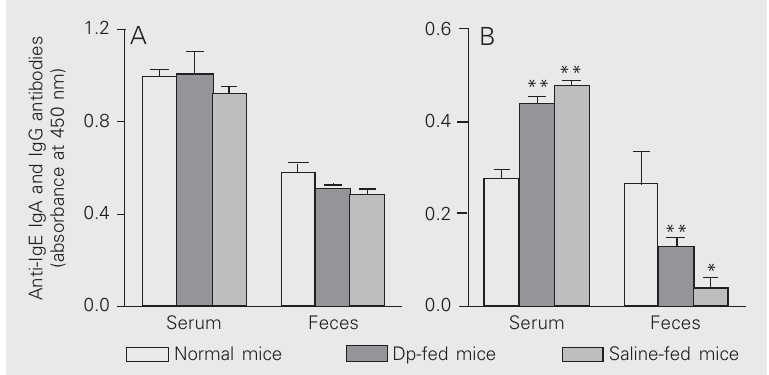
Figure 6. Determination of anti-IgE IgA and IgG antibodies in serum and feces. Sera and fecal extracts obtained from mice fed a Dermatophagoides pteronyssinus (Dp) and from saline-fed mice on the 28th day post-immunization (dpi) were assayed for IgA against the IgE molecule (anti-Dansyl, κ chain) (A) or for IgG against the IgE molecule (B). Data are reported as means ± SEM for 3-5 mice in each group of four independent experiments. *P < 0.05 compared to mice fed the Dp extract; **P < 0.05 compared to normal mice (unpaired Student t